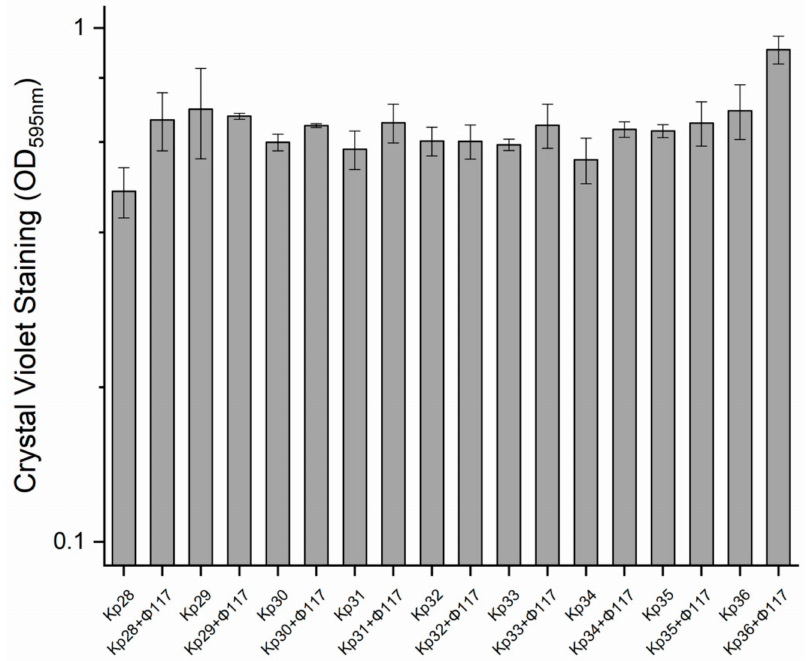
Figure 5. Biofilm formation of K. pneumoniae strains in cultures pretreated with phage 117, and control cultures, quantified by crystal violet (OD595nm, left y-axis). Error bars represent the actual ranges of data from all experiments carried out in